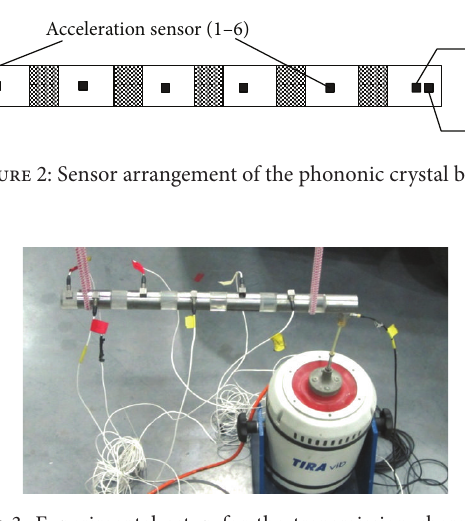
Figure 3: Experimental setup for the transmission characteristic